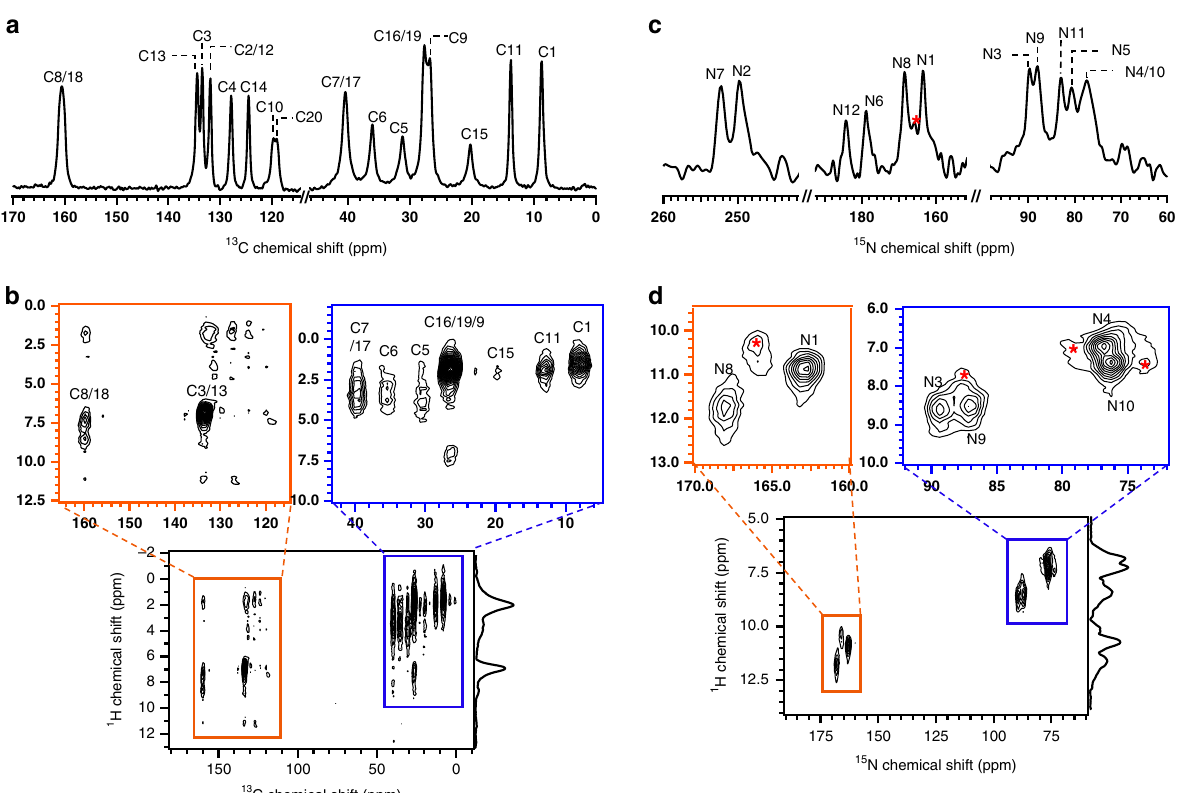
Fig. 4 Structural assignment of cimetidine form B using SSNMR spectra. The SSNMR spectra were measured for a mixture of forms B and C. a 1D 13 C and c 15 N CPMAS spectra measured using 500 and 5000 scans, respectively. The CP contact time was adjusted to 2 ms for 13 C and 1 ms for 15 N. Only the spectral range of interest is displayed. b 2D 1 H – 13 C and d 1 H – 15 N HETCOR spectra over the full spectral range with expansions of the regions of interest as indicated by the blue and orange boxes. The atom labels are identical to those shown for CB2 in Fig. 5b. The contact time was 2 ms during the fi rst CP transfer and 0.5 ms during the second CP transfer for both spectra. The 2D 1 H – 13 C spectrum was acquired using 40 scans and 128 rows in the indirect dimension and the 2D 1 H – 15 N spectrum was acquired using 24 scans and 64 rows. The 1 H – 15 N correlation peaks from form C are indicated with red asterisks